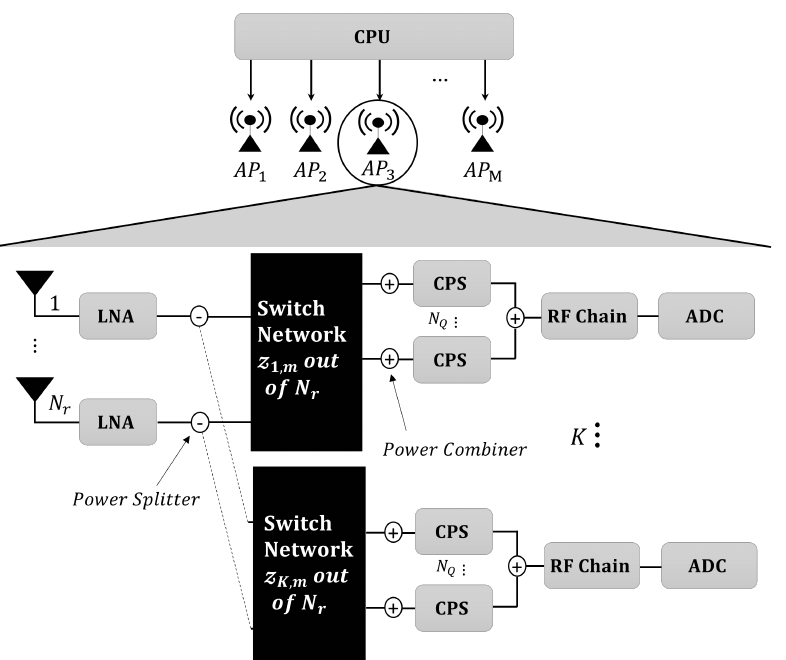
Figure 1. Hybrid beamforming structure for each AP in uplink cell-free massive MIMO systems with CPSs connected to RF chains via switch